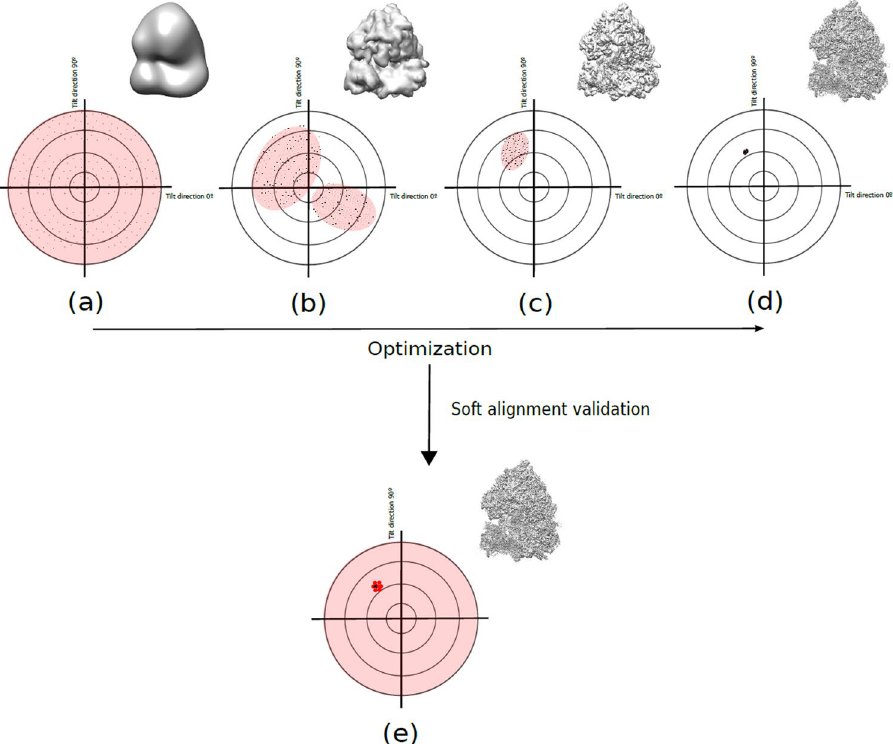
Figure 3. Typical alignment procedure performed for each particle. Starting from a low-resolution initial model the alignment method performs a global angular search with low angular sampling ( a ). This global search converts to a local one (increasing the angular sampling) as the number of iterations and the map resolution increases ( b – d ). Our proposed approach angular accuracy estimation is based on re-computing the particle orientation by a global search using the final reconstructed map ( e